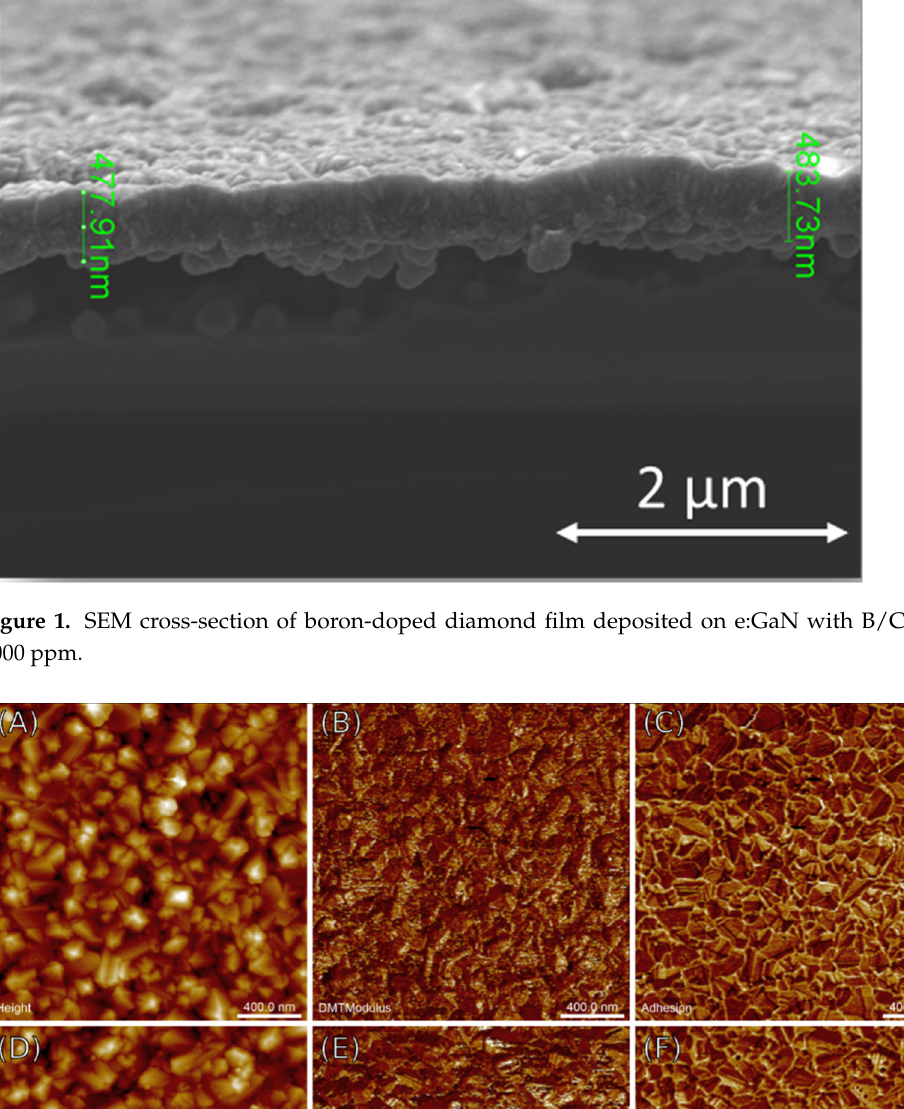
hibit surface morphologies of the BDD samples common for polycrystalline, closed films served crystal habits defined by the specific shape of their facets (either triangular or rec- tangular) and sharp edges confirm the presence of well-developed polycrystals that took control of the growth space during the nucleation step but are spatially confined so that they can further expand only within the competitive growth regime.